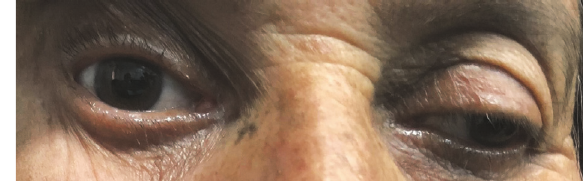
Figure 5: Photograph showing the manually lifted right eye lid demonstrating mydriasis and impaired adduction of right eye.